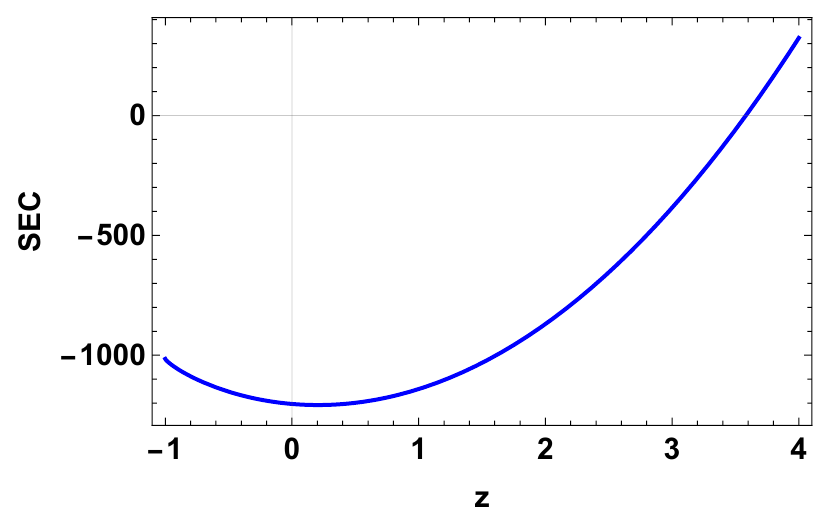
Figure 8. Behavior of the DEC vs. redshift.